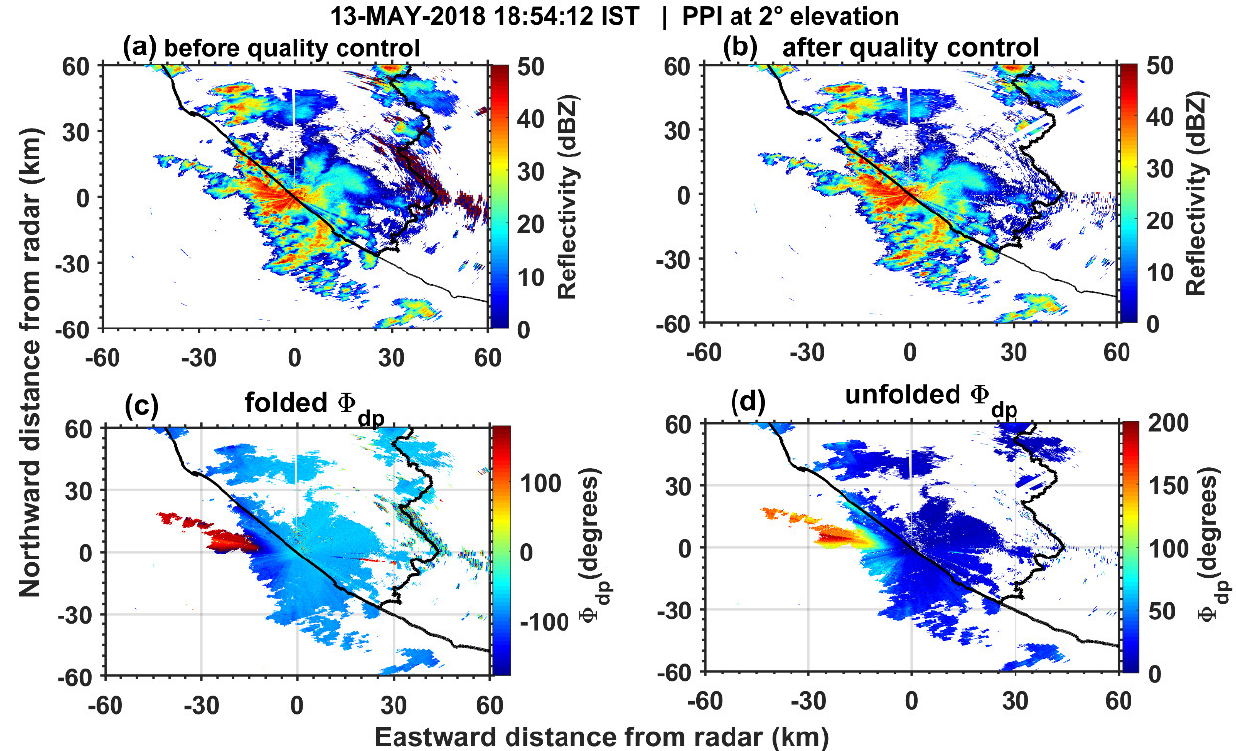
Figure 2. PPI diagrams of radar reflectivity at 2° elevation ( a ) before quality control and ( b ) after quality control. PPI diagrams of ( c ) folded Φ dp and ( d ) unfolded Φ dp at 18:54:12 IST, 13 May 2018.